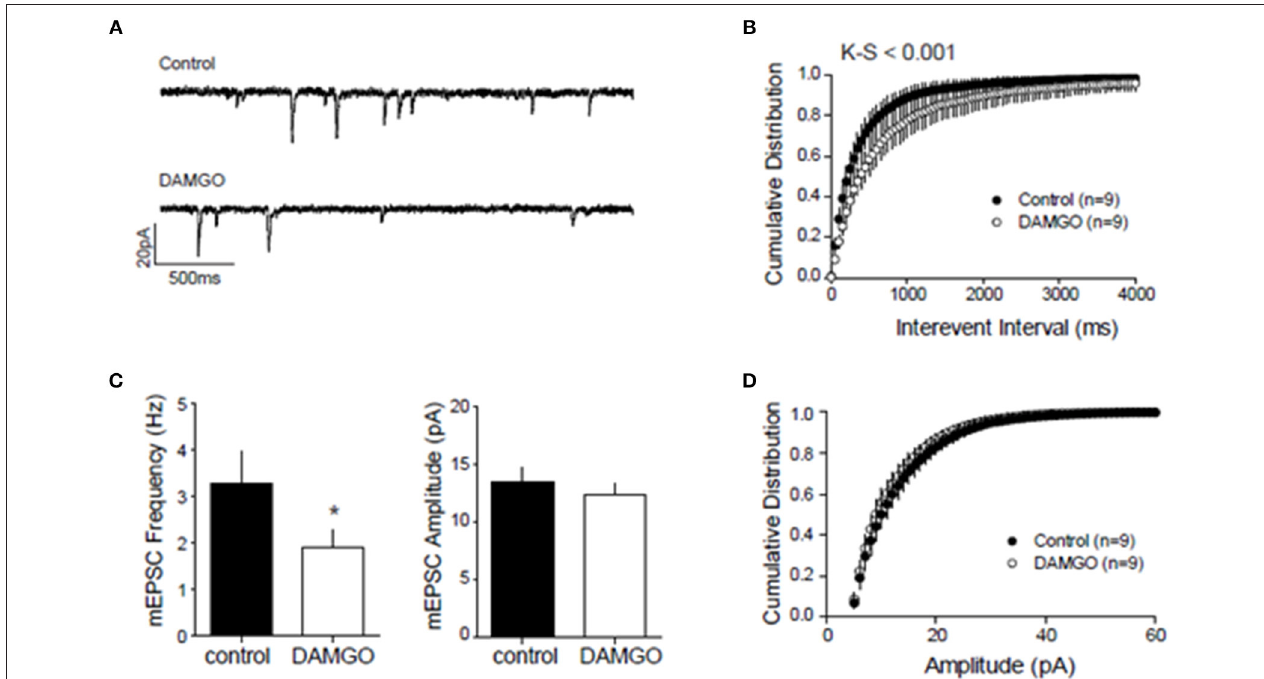
FIGURE 6 | Presynaptic inhibitory CB1 and MOR interact at excitatory NAcC synapses. To localize the inhibitory action of DAMGO on excitatory NAcC synapses, we recorded miniature EPSCs by whole cell recordings in NAcC medium spiny neurons (MSN) clamped at –70 mV. mEPSC frequency and amplitude were calculated in the 10-min interval before and after 20 min of bath application of 10 µ M DAMGO. Effect of DAMGO on miniature excitatory events in NAcC MSN: (A) Representative mEPSC of recordings before (control) and after DAMGO bath application; (B) Cumulative probability distribution of intervals between events showing a shift to the right after DAMGO and the length of inter-event interval was markedly increased [Kolmogorov-Smirnov (K-S), p < 0.001]; (C) Lower mean mEPSC frequency but no change in mean amplitude after DAMGO ( N = 9 for both groups, * p < 0.05 by paired t -test); (D) Cumulative probability distribution of mEPSC amplitude showing no change. The cumulative distribution [(K-S) test; n.s.] and mean amplitude of the mEPSC remained unchanged after DAMGO application (CTRL: mean 13.46 ± 1.2 pA; DAMGO: mean 12.28 ± 0.99 pA; paired t -test). Error bars represent